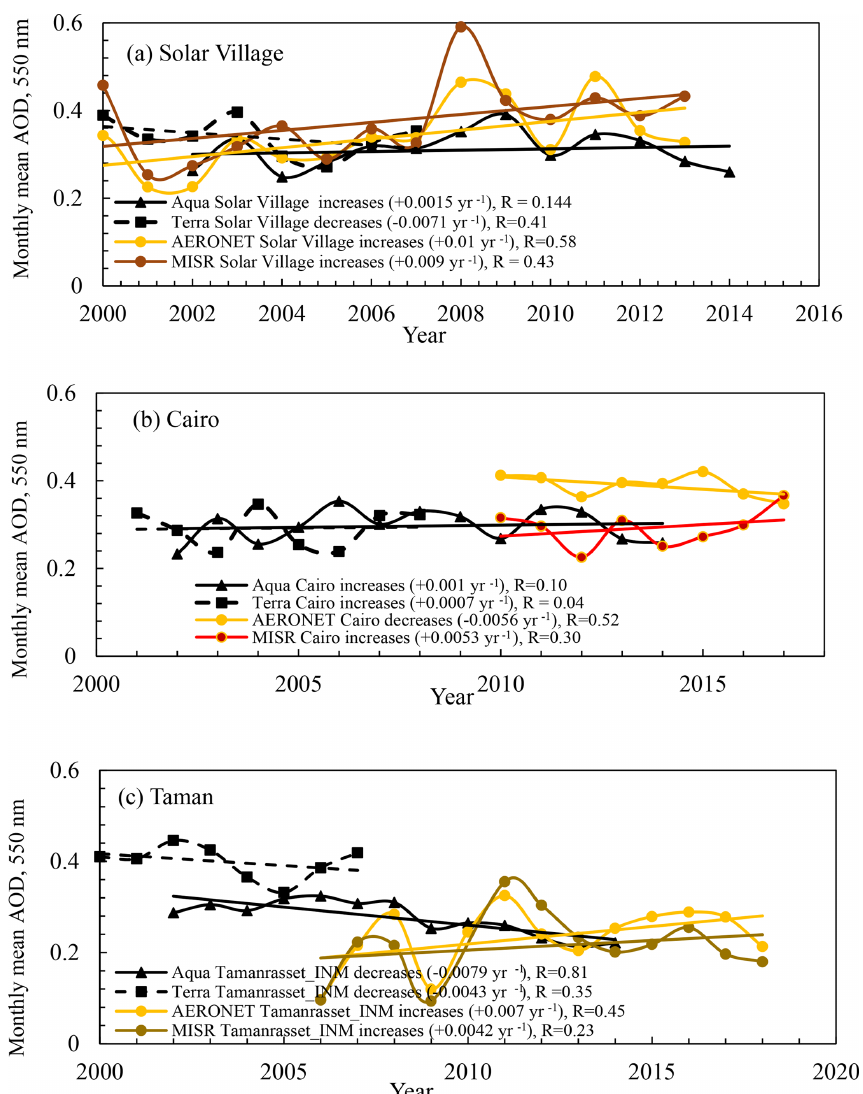
Figure 4. Time series of monthly mean AOD derived from MODIS/Aqua, MODIS/Terra, MISR, and AERONET over (a) dust-, (b) biomass- burning, and (c) mixed-aerosol-dominated aerosol